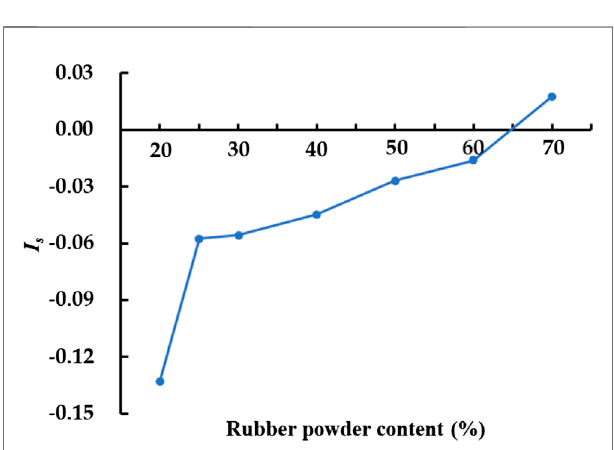
FIGURE7| Thechangeofsegregationrateatvariousrubberpowdercontents.